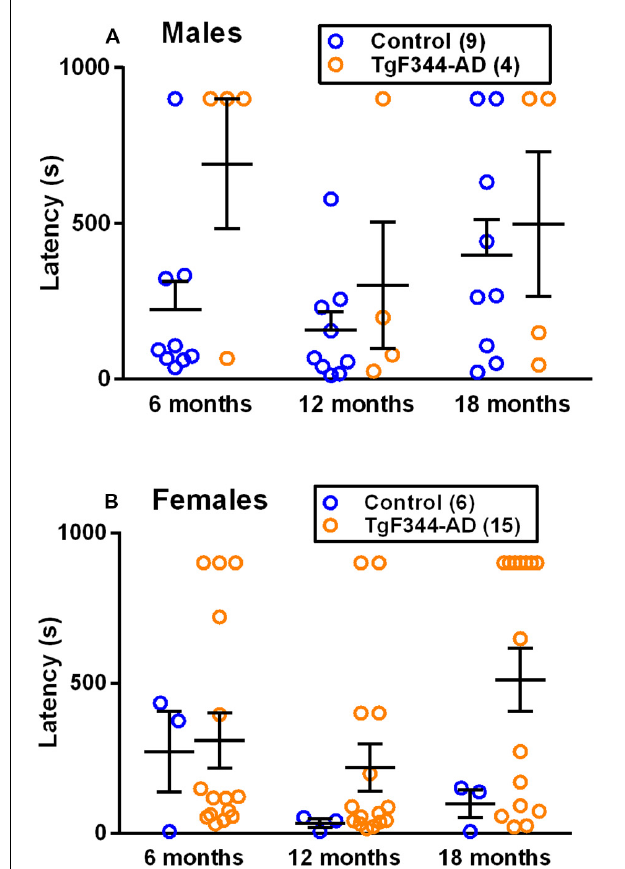
FIGURE 2 | Performance on the buried food task in (A) male and (B) female TgF344-AD and control rats. Each point is the latency to find the buried food, and the lines represent the mean ± SEM for the number of male and female control and AD rats indicated in parentheses. The main effect of genotype was statistically significant ( p = 0.047) in males but not in females. Latency to find the buried food was longer in male AD rats compared to